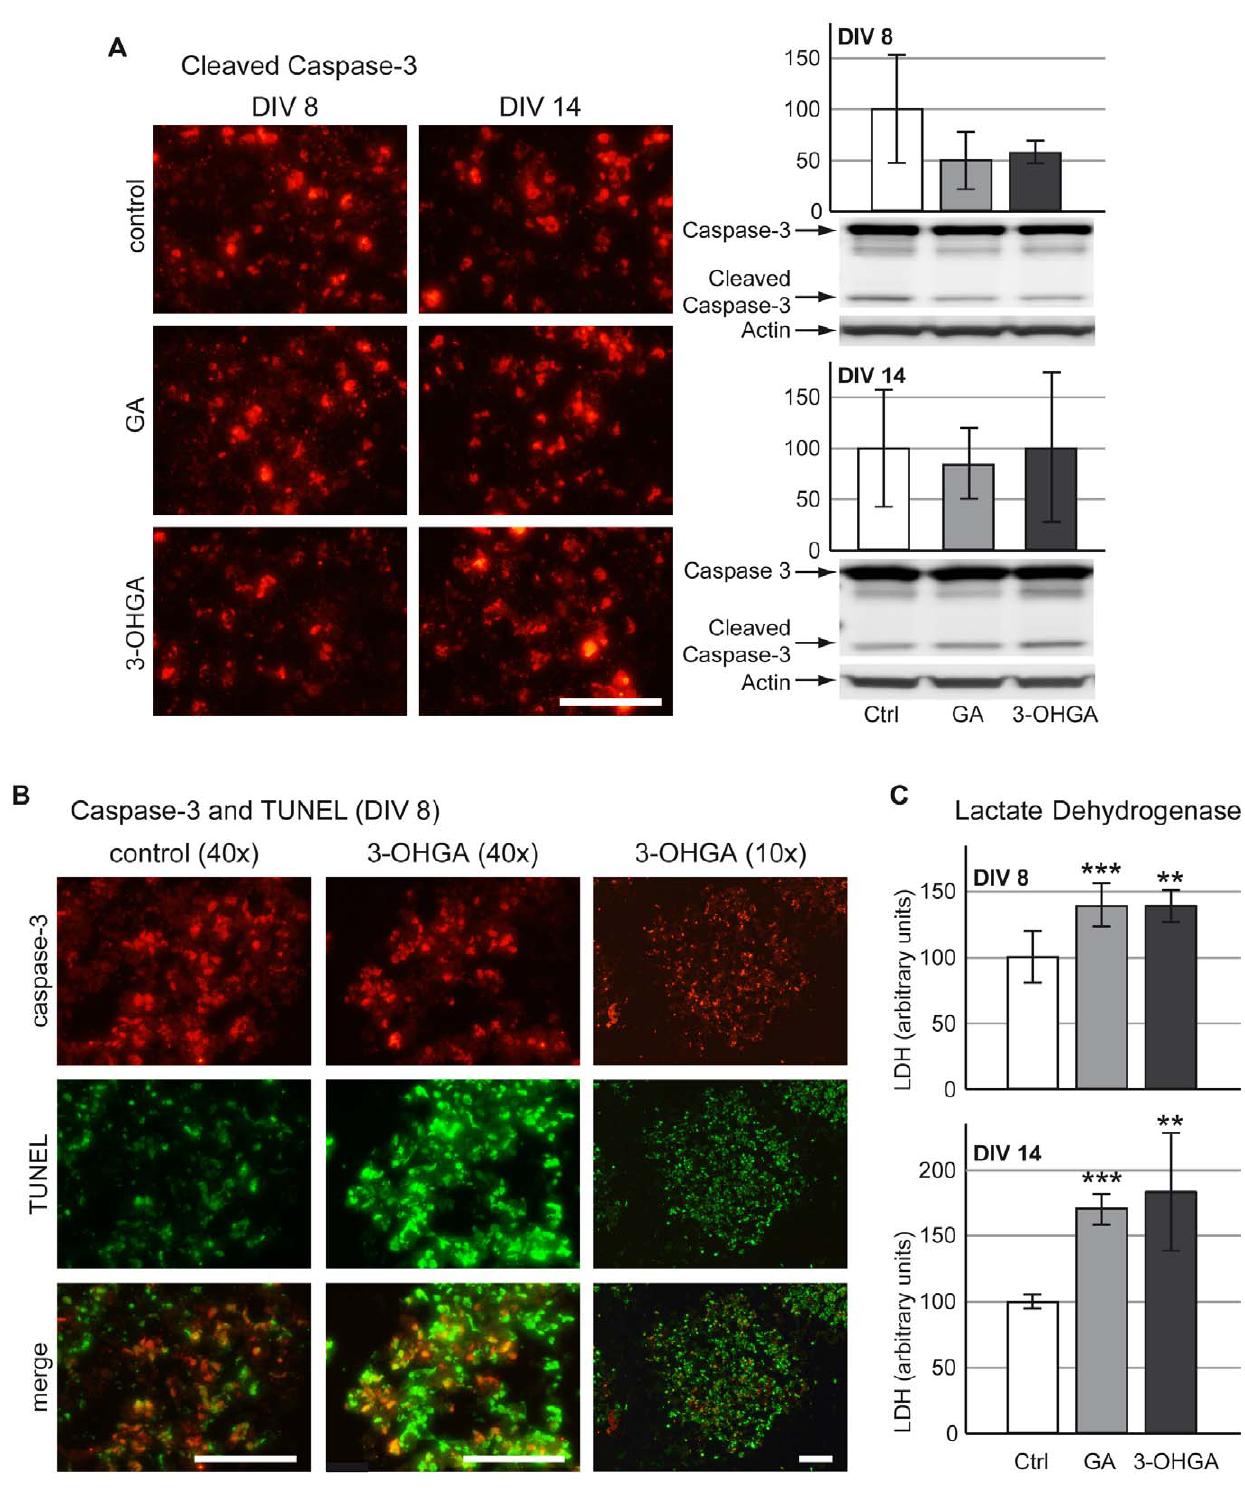
Figure 6. Evaluation of cell death after treatment with GA and 3-OHGA. (A; left panel) Immunohistochemical staining for cleaved caspase-3 (red signal). Scale bar: 100 m m. (A; right panel) Representative western blots with data quantification of whole-cell lysates for full length caspase-3 and the large fragment of cleaved (e.g. activated) caspase-3 for protocol A (DIV 8, above) and protocol B (DIV 14, below). Actin was used as a loading control. The quantifications of cleaved caspase-3 are expressed as percentage of respective controls. The values represent the mean 6 SEM from 3 replicates taken from 2 independent experiments. (B) In situ cell death assay with TUNEL (green signal) and cleaved caspase-3 (red signal) on DIV 8 (protocol A). Merge of both signals leads to double-stained cells appearing in yellow. Scale bar: 100 m m. (C) LDH in culture medium of cultures from protocol A (DIV 8, above) and protocol B (DIV 14, below). Mean 6 SD of 7 replicate cultures assessed by Student’s t -test; **p , 0.01, *** p , 0.001.